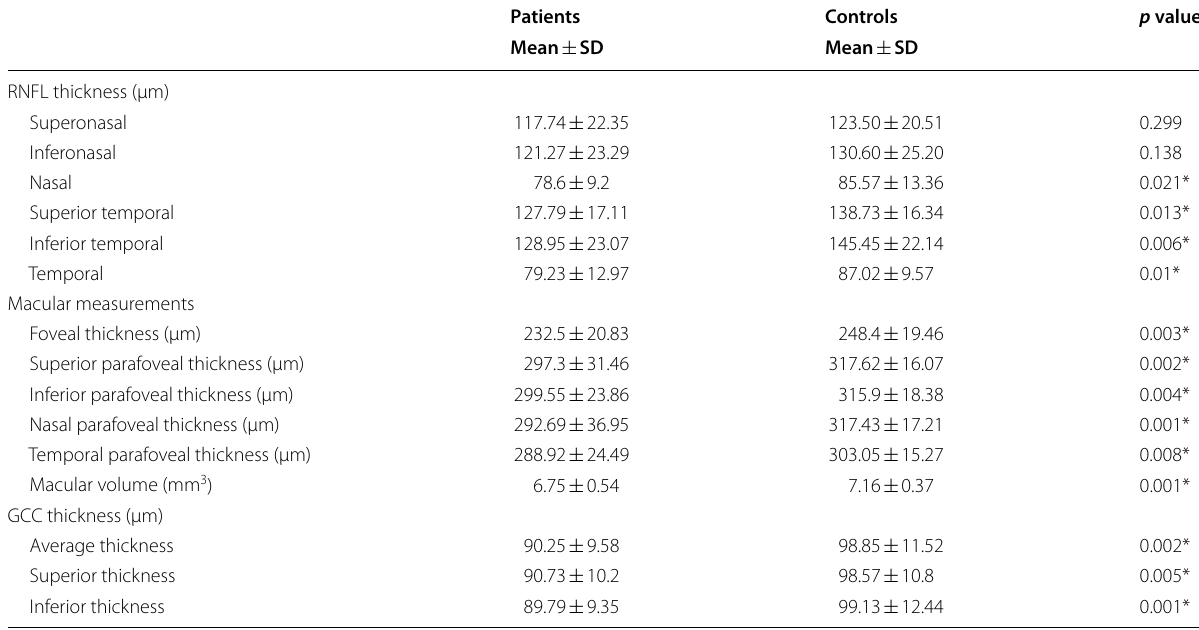
Table 2 SD‑OCT parameters in PD patients versus